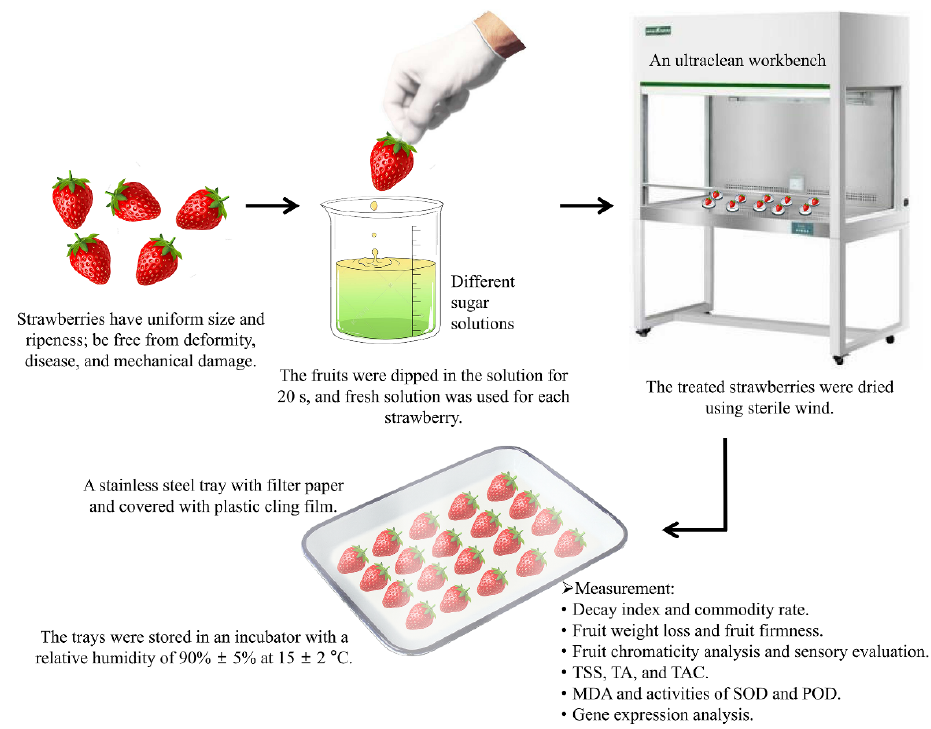
Figure 1. Experimental process flow chart. TSS, total soluble solids; TA, titratable acidity; TAC, total anthocyanin content; MDA, malondialdehyde; SOD, superoxide dismutase; CAT, catalase. According to the results of the sugar concentration screening experiment, the ap- propriate concentration of various sugar solutions was determined for subsequent